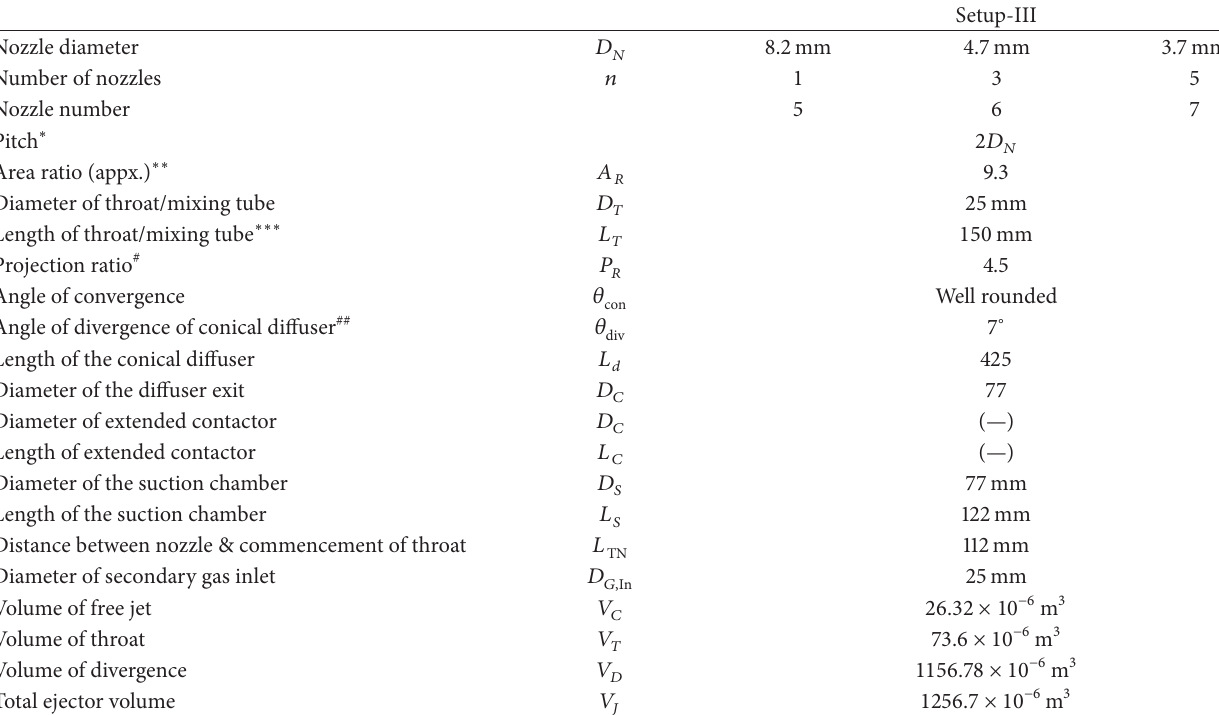
Table 1: Dimensions of ejector [31, 111, 112].